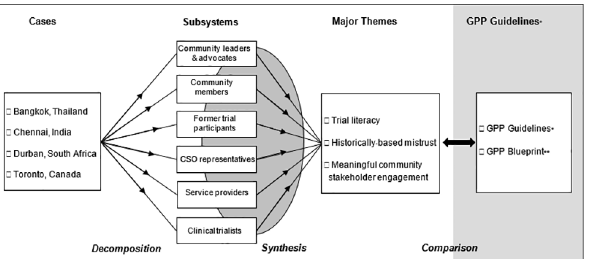
Fig 1. Conceptual model of multiple case study design. CSO: civil society organization, * Good Participatory Practice Guidelines for Biomedical HIV Prevention Trials [1]. ** GPP Blueprint for Stakeholder Engagement (AVAC)